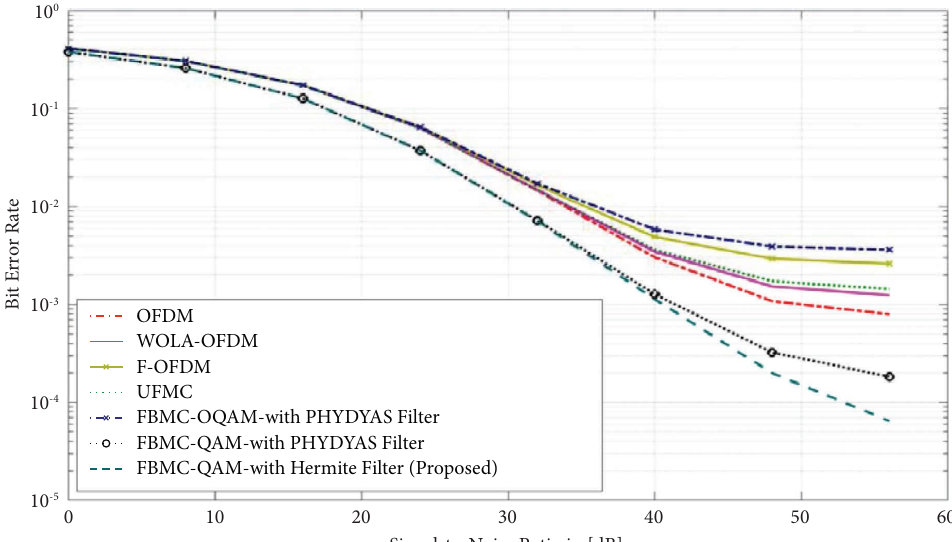
Figure 10: Bit error rate performance of diferent multicarrier modulation techniques for vehicular A channel model at 256 QAM.